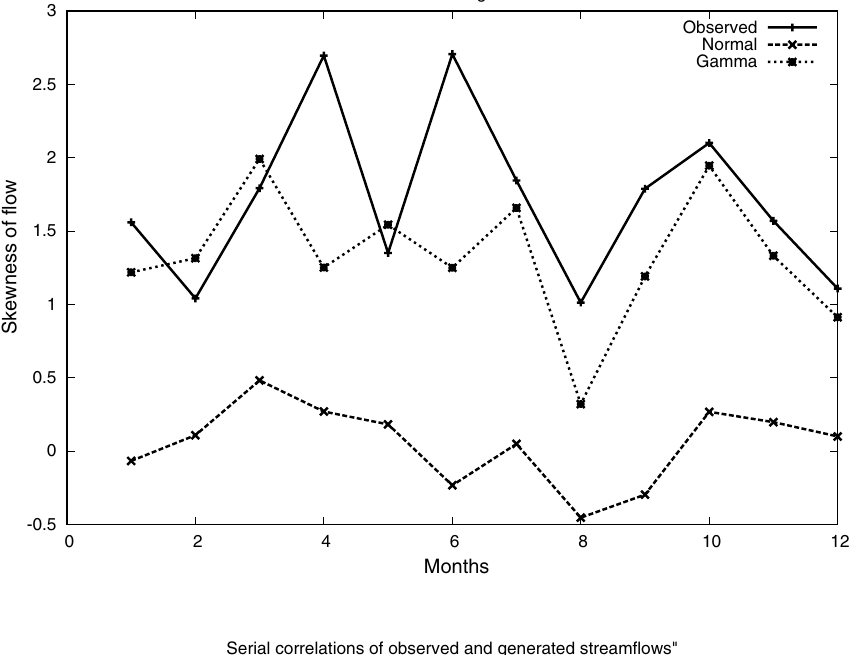
Fig. 18 Historical and generated monthly serial correlations of flows in Barakar River (multi- site